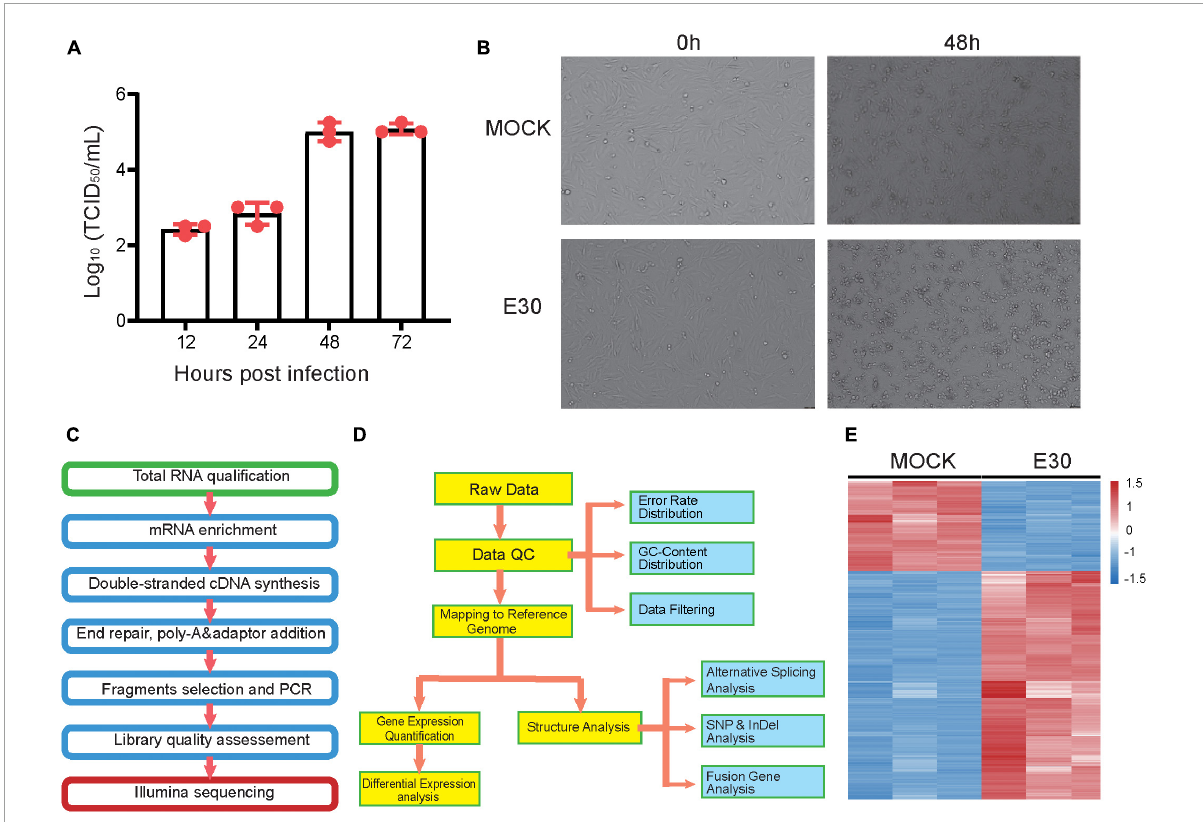
FIGURE1 Expression profile for echovirus 30 infection in human glioma (U251) cells. (A) Change in E30 viral titer in U251 cells, (B) CPE appeared at 48 h after infection of U251 cells with E30, (C,D) sequencing and information analysis flow chart, and (E) heat map analysis of E30-infected and control group (each group, n =